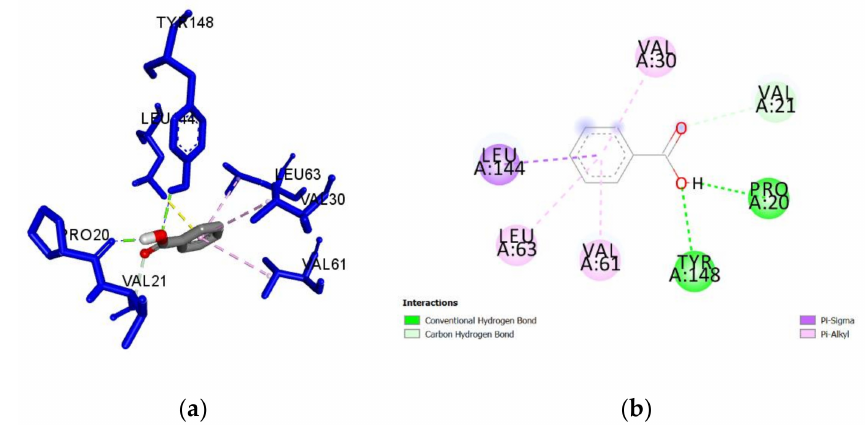
Figure 3. ( a ) Docked pose of benzoic acid in the Pa DsbA1 binding site showing molecular interactions— hydrogenandhydrophobicbondsshownasgreenandpink / purpledashedlines, respectively; ( b )2Dplot of interactions between benzoic acid and key residues of Pa DsbA1 generated by BIOVIA Discovery Studio